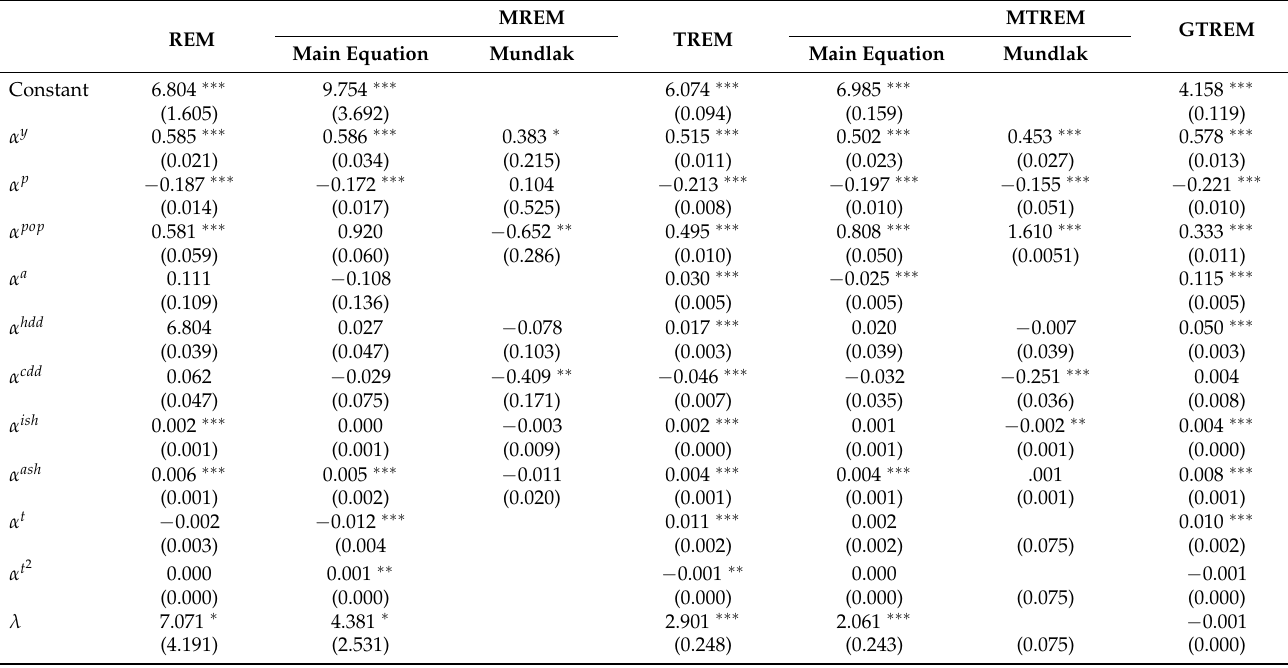
Table A2. Summary of SFA studies on energy